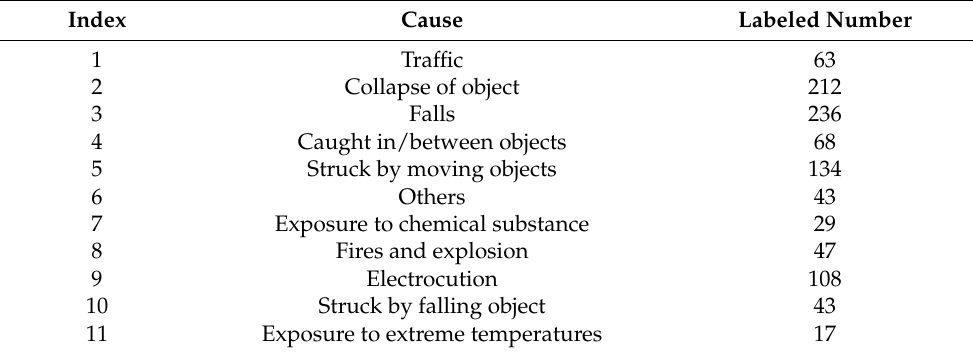
Table 1. Labeled cause distribution of dataset provided by Goh and Ubeynarayana